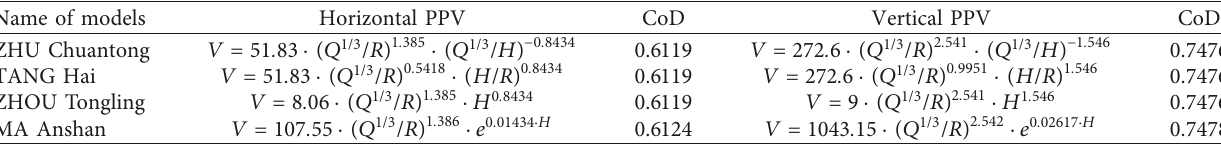
Table 6: Fitting results of PPV considering the elevation.